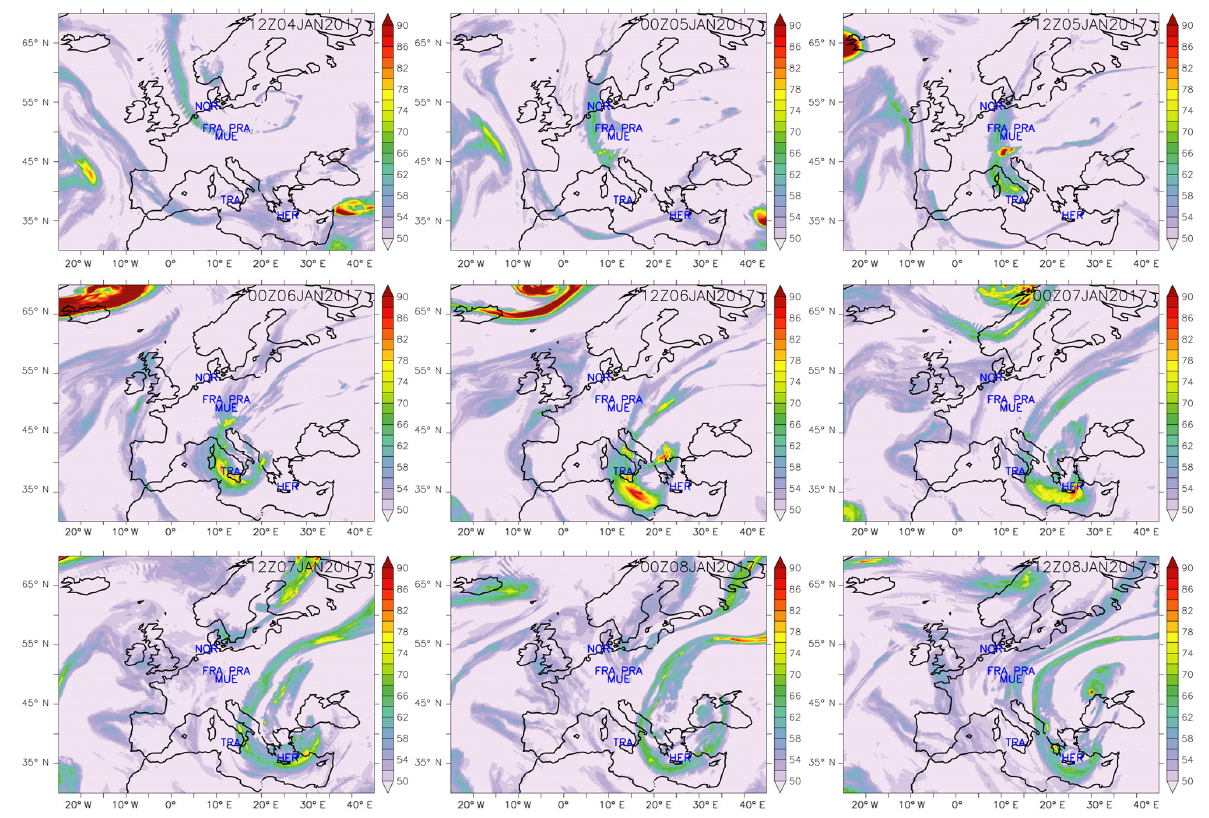
Figure 4. RegEns ozone mixing ratio (in ppb; colour shaded) at 5000m during the period from 12:00Z on 4 January 2017 to 12:00Z on 8 January 2017 (12h interval). Also shown are the locations of the observational sites (blue text) used in the